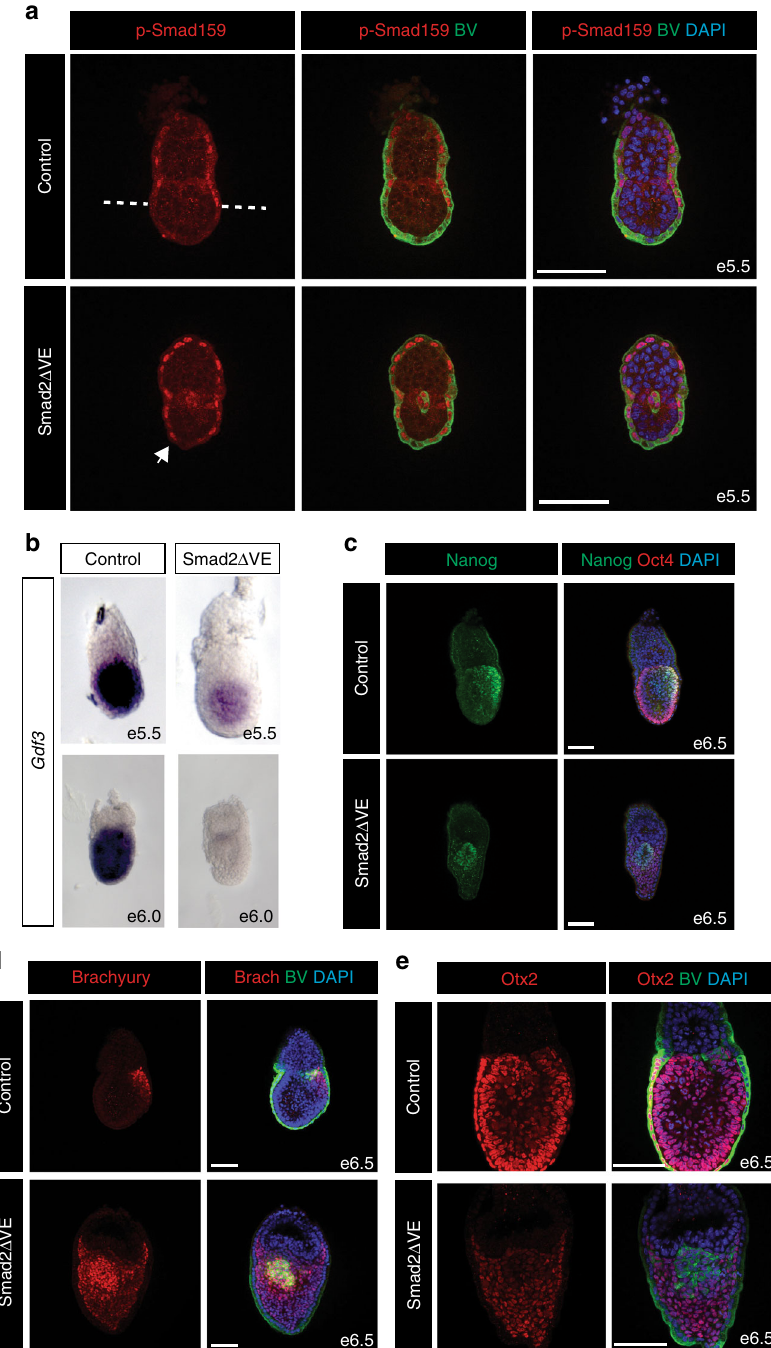
Fig. 1 Imbalanced Bmp/Nodal signalling and expansion of the PGC niche caused by Smad2 inactivation in the VE. a Representative images of p-Smad159 immuno fl uorescence (IF) staining of e5.5 embryos carrying the Blimp1-mVenus (BV) transgene, counter stained with DAPI. Dashed line indicates extent of proximal p-Smad159 staining in control embryos. The arrow indicates expanded p-Smad159 in the distal VE of Smad2 Δ V embryos. b Whole-mount in situ hybridisation analysis of Gdf3 expression in control and Smad2 Δ VE embryos at e5.5 and e6.0. c Nanog and Oct4 co-staining in e6.5 control and Smad2 Δ VE embryos. d Brachyury IF in e6.5 control and Smad2 Δ VE BV-expressing embryos. e Otx2 staining and BV expression at e6.5. All IF staining images were counter stained with DAPI. Scale bars = 100 μ